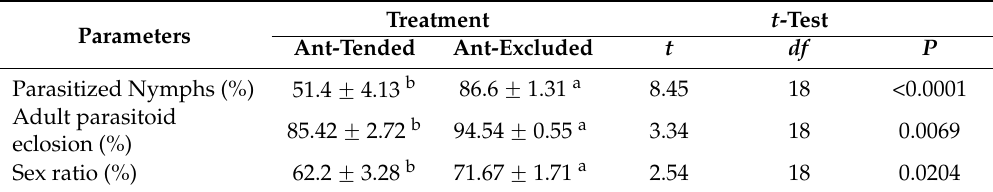
Table 1. Mean ( ˘ SE) percentage parasitism, adult parasitoid eclosion and sex ratio of Anagyrus pseudococci after 24 h exposure period to third instar nymphs of Rastrococcus iceryoides in the presence and absence of O. longinoda .